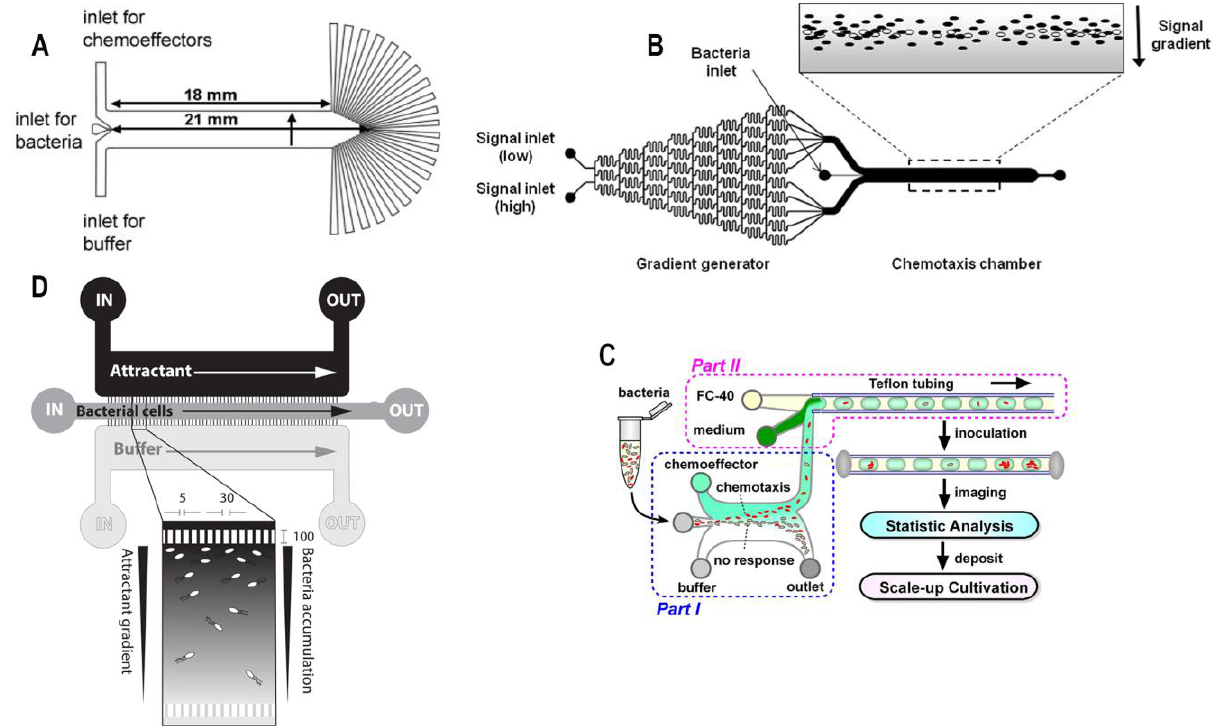
FIGURE 3: Microfluidic devices for bacterial chemotaxis (flow-conditions). (A) A microfluidic chip with three inlets (one for chemo effectors, other for buffer and middle for bacterial culture), the main channel and terminated by outlets of 22 microchannels. Reproduced from [32]. (B) Schematic diagram of 'μFlow' - multiple chemo-gradient generators. The chip consists of a gradient generator and a chemotaxis chamber. Single or mixture of chemo effectors was introduced from one of the inlets. When the chemo effectors were passed through the microstruc- ture, single or multiple chemical gradients were formed across the chemotaxis chamber. In the presence of high chemorepellents concentra- tion (grey) at the lower end of the chemotaxis chamber, chemotactic bacteria tend to concentrate at the upper end. Reproduced from [33]. (C) Chemotaxis-based automatic sorter. Chemo effectors and buffer were injected from the two side-inlets to create chemical gradients, whereas bacterial sample was subjected from the middle inlet (Part I). Chemotactic motile bacteria were sorted as they swam towards the outlet by chemotaxis Eventually, each sorted bacterium was encapsulated as a single cell inside a droplet and collected in Teflon tubing (Part II) and imaged for analysis and cultivated in soft agar plates to test the cell viability. Reproduced from [18]. (D) A chemical gradient was generated across the middle channel (injected with bacterial culture) by connecting the source of chemoattractant and buffer with numerous micron- sized channels. Reproduced from